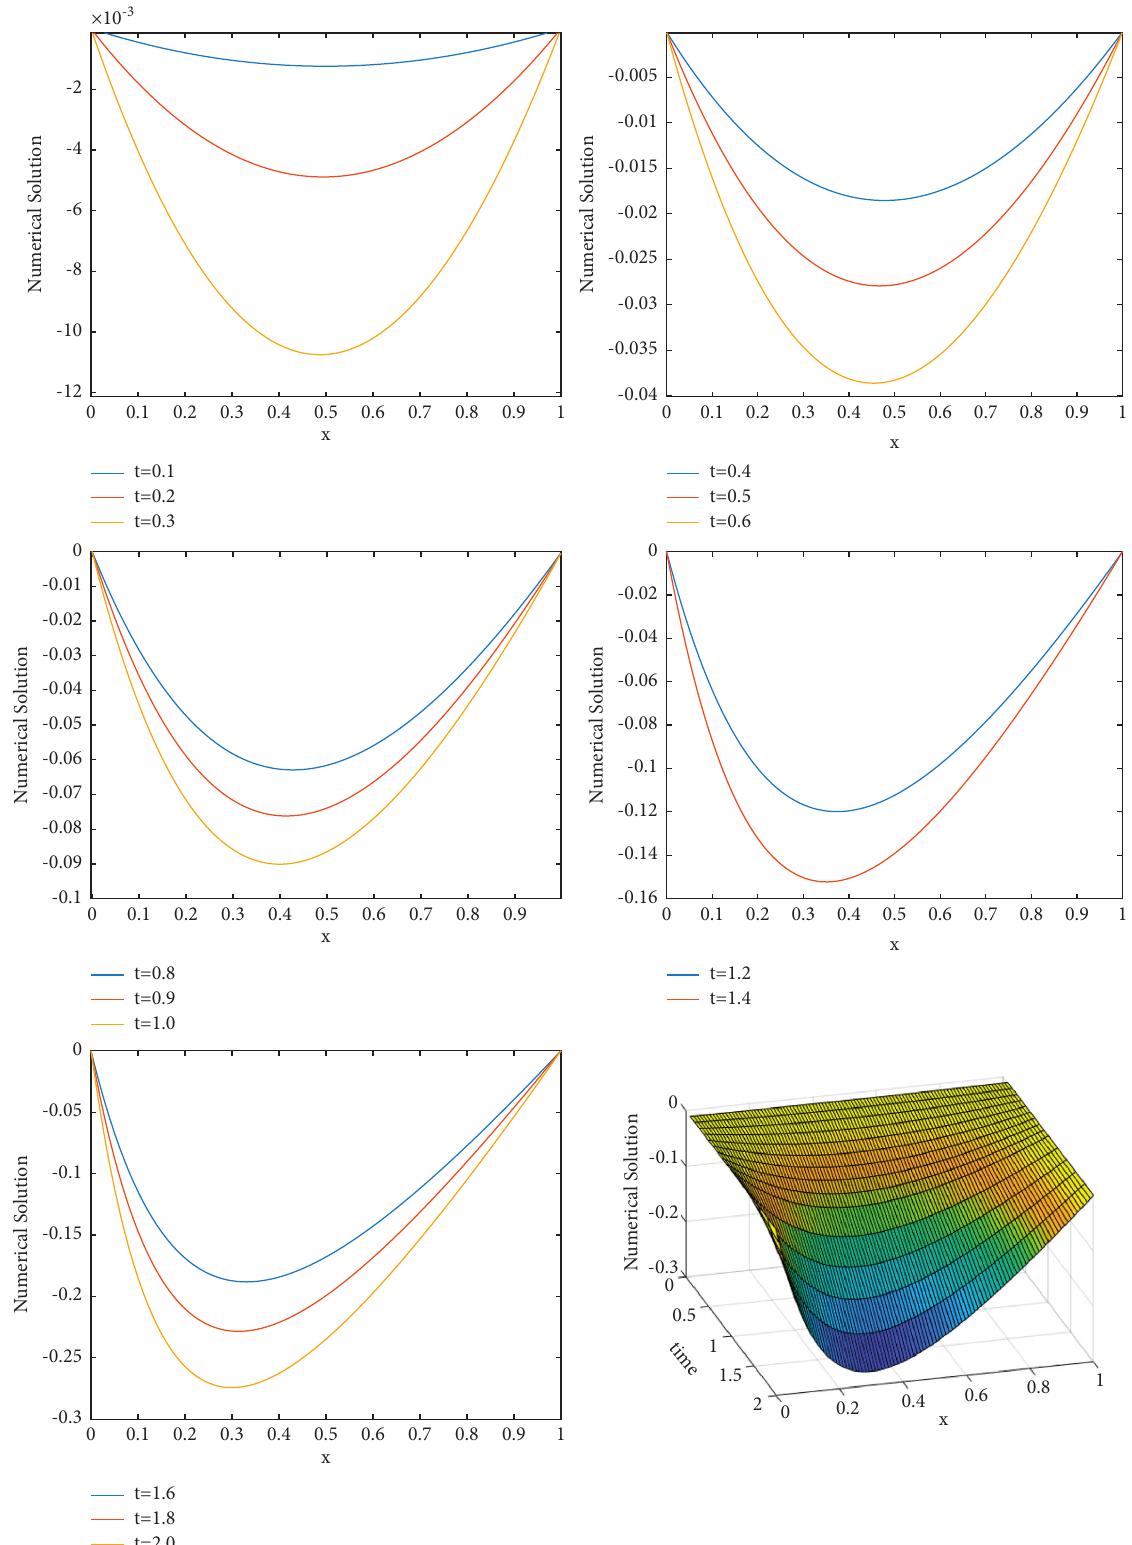
Figure 5: Solution behavior of the mode at different time with parameter ε � 10 − 4 , μ � 10 − 10 and M �